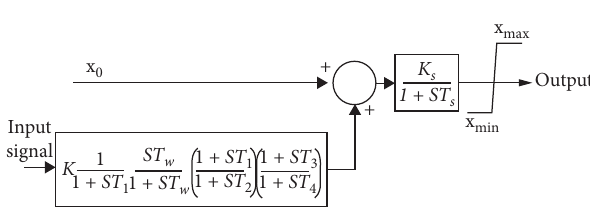
Figure 9: TCSC block diagram along with the